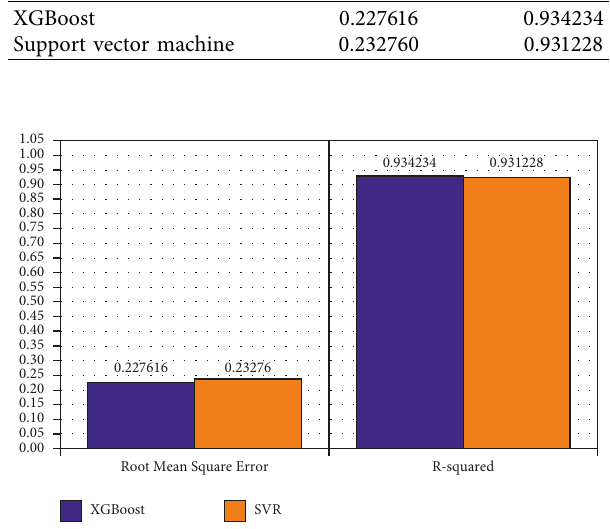
Figure 26: Comparison between the RMSE and R-squared values of XGBoost and SVR for Boro yield Prediction.